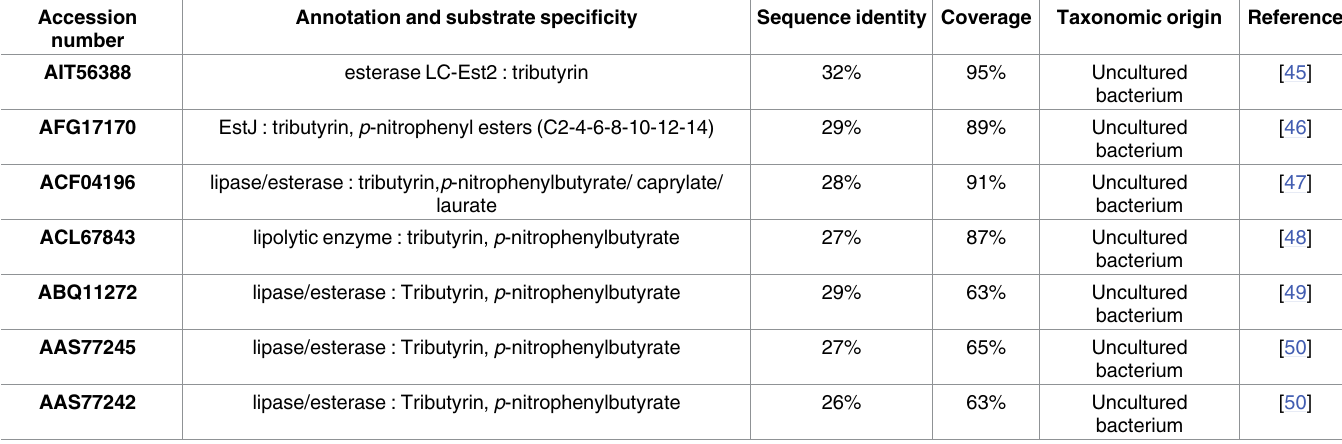
Table 2. Characteristics of the characterised enzymeswith more than 25% identity with CE_Ubrb. Annotation and substrate